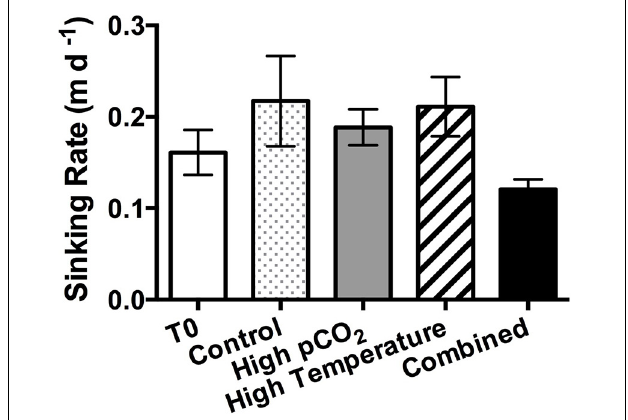
FIGURE 7 | Sinking rates of the phytoplankton community in the beginning of the incubation (T0) and in the four experimental treatments on the final sampling day. Values are the means and error bars are the standard deviations of triplicates.